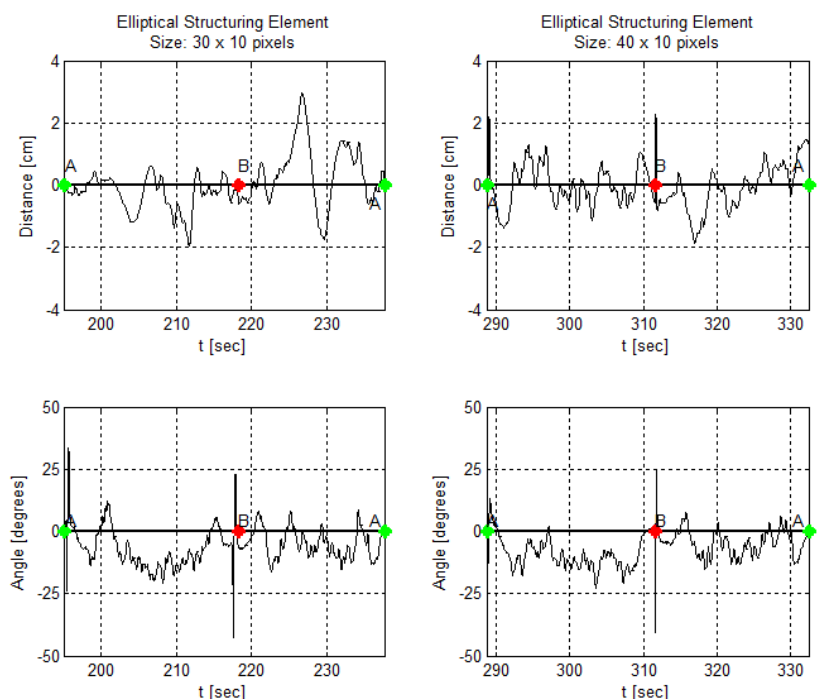
Figure 25. AGV angle and distance measures using an elliptical kernel in the morphological operation at the image processing step.